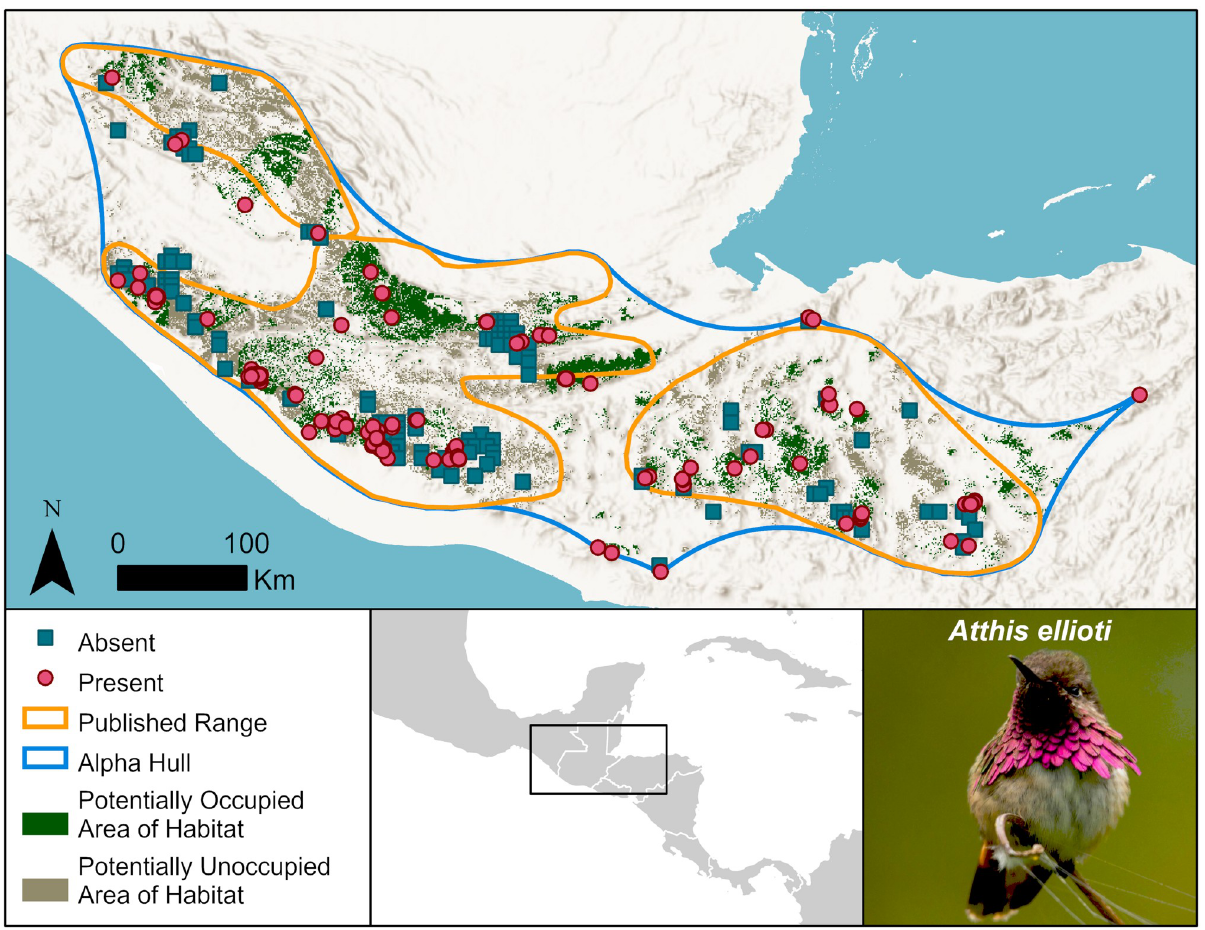
Fig 6. Distribution of the wine-throated hummingbird, Atthis ellioti . The published range boundaries are large, but extensive deforestation has left the remaining forests few and fragmented, resulting in a much smaller Area of Habitat. Symbology is simplified to show absences (blues squares) as the centroids of absence grid cells. Basemap provided by USGS and photo provided by David Mora Vargas (Macaulay Library, ML296645721).